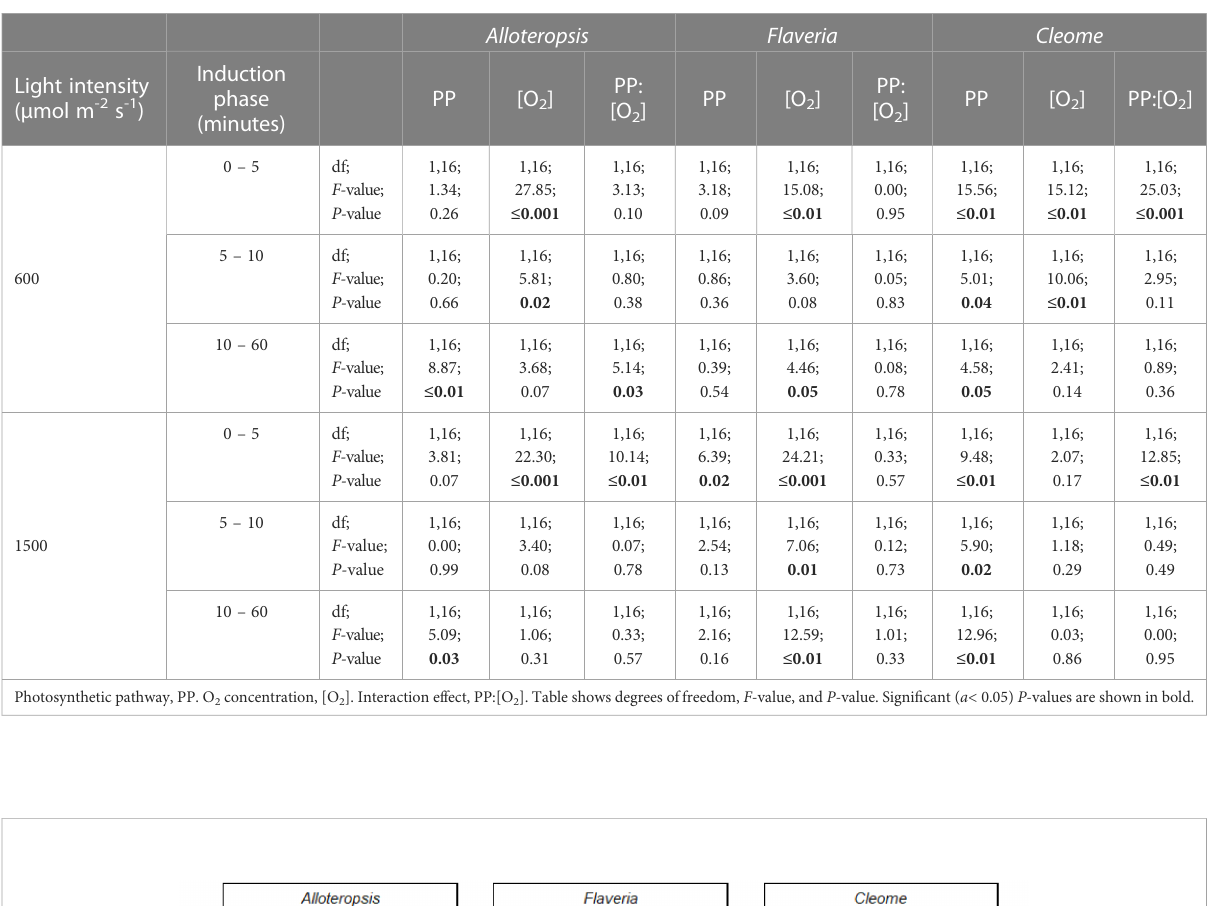
TABLE 3 ANOVA table of the carbon assimilation AUC of different phases of light induction for phylogenetically linked C 3 and C 4 Alloteropsis , Flaveria and Cleome species.